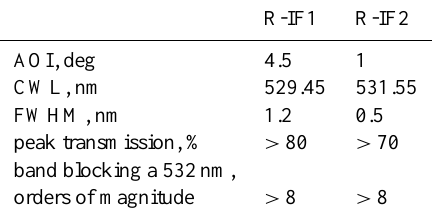
Table 2. Filter parameters (angle of incidence (AOI), central wave- length (CWL), full width at half maximum (FWHM)) used in the new rotational-Raman receiver branch. The values are taken from the manufacturer’s data sheet (Barr Associates, MA, USA).